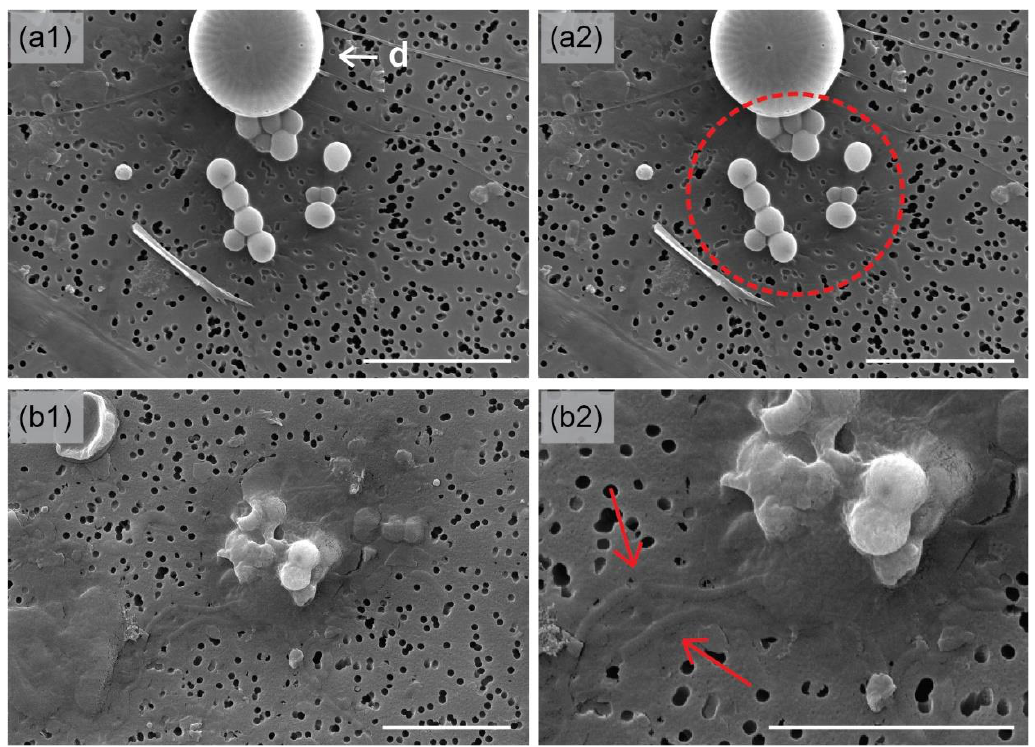
Figure 5. Morphology of the organic matter surrounding the MgAs micropearls (MC5). Secondary- electron SEM image of a dried filter. Sample ( a ) was filtered and dried, while sample ( a1 ) shows the raw image and ( a2 ) shows an approximate delimitation of the dried cell in which the micropearls were formed; ( b ) was fixed with alkaline lugol before filtration; therefore, the organism is better preserved, allowing the observation of two flagella (detail shown on image ( b2 )). Pores of the filter (0.2 µm) appear as small black dots. Water samples taken in Lake Geneva at ( a ) SHL2 location, 10 m depth, 11.05.2015, ( b ) GE3 location, 10 m depth, 21.04.2016. d: diatom. Scale bar: 5 µm.